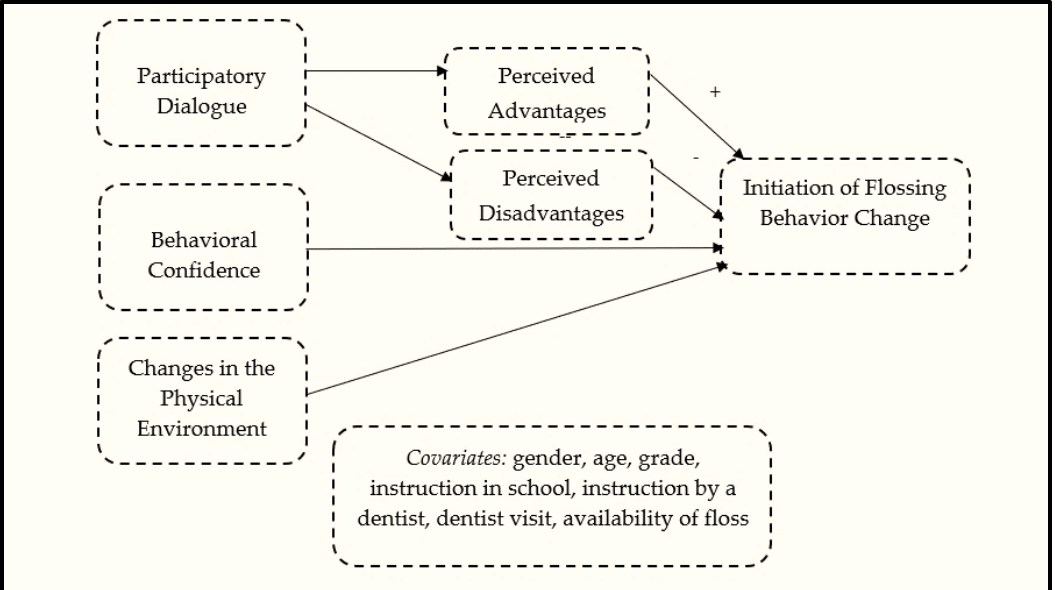
Figure 1. Diagrammatic depiction of the initiation model of the MTM for promoting flossing among African American/Black and Latinx/Hispanic adolescents.